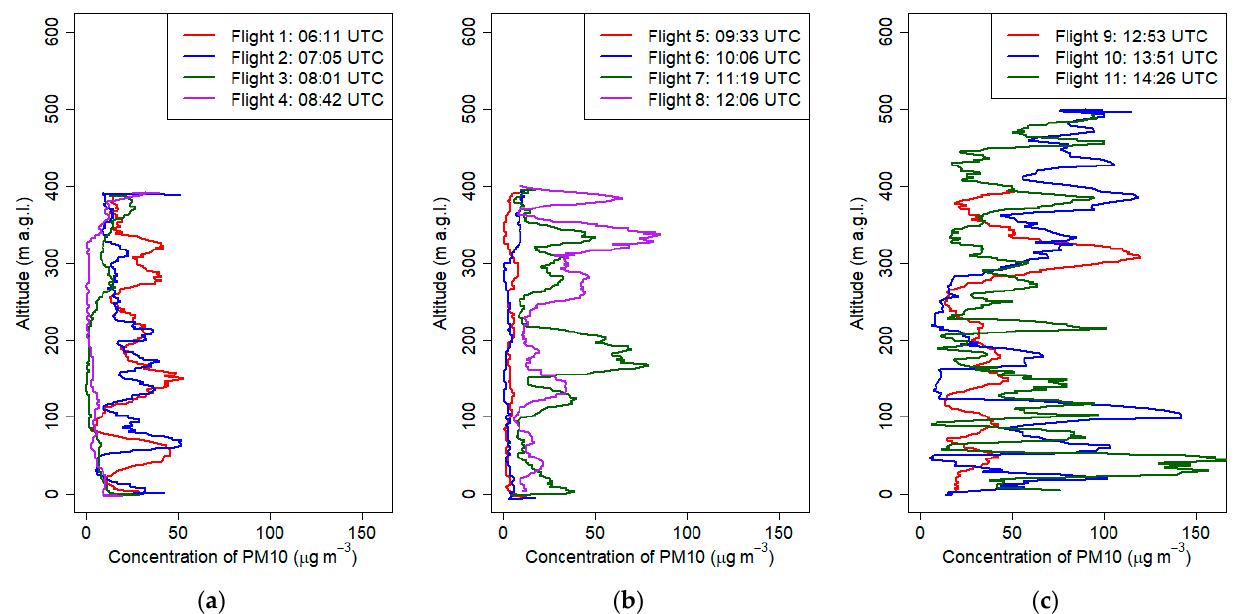
Figure 17. Vertical profiles of PM 10 concentration on March the 7th, 2019 from 6:00 UTC to 15:00 UTC.